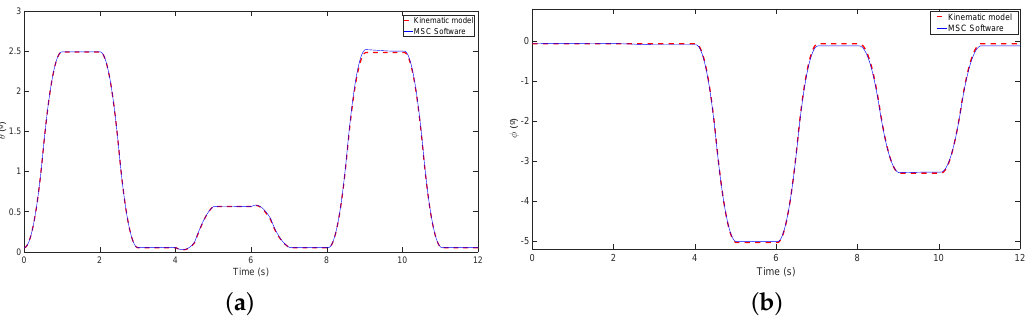
Figure 9. ( a ) validation of the pitch angle ( θ ); ( b ) validation of the roll angle ( φ ). The maximum errors of the orientation in the co-simulation are E h = 0.3 mm, E θ = 0.07 ◦ and E φ = 0.07 ◦